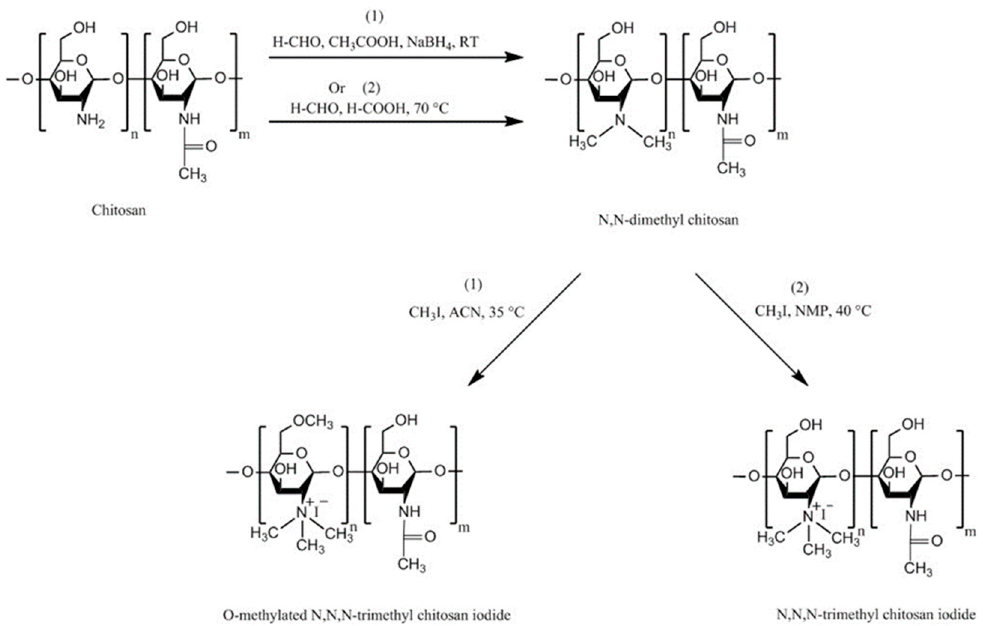
Figure 4. Synthetic pathway for preparation of TMC using indirect trimethylation approach according to (1) Muzzarelli and Tanfani [50], ACN = acetonitrile and (2) Verheul et al. [51] avoiding O -methylation, NMP = N -methyl-2-pyrrolidinone.